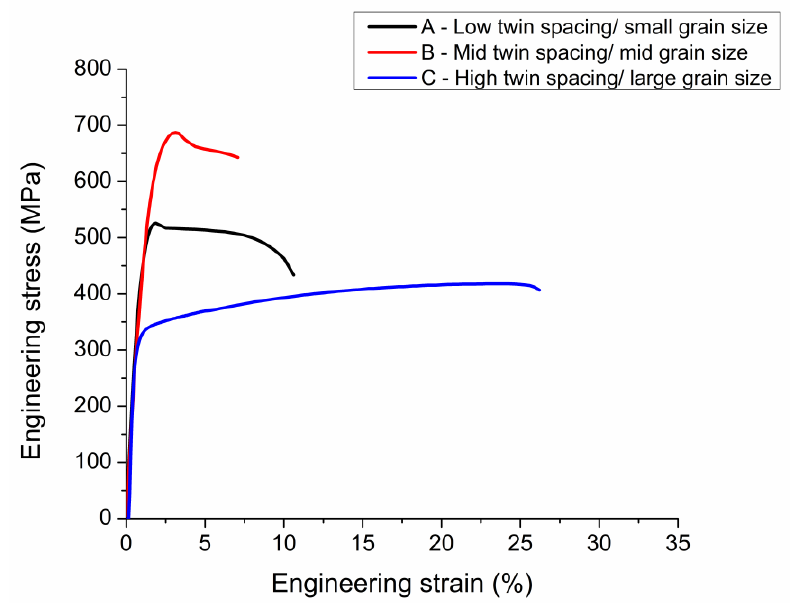
Materials 2020 , 13 , x FOR PEER REVIEW 6 of 11 Figure 4. Stress–strain curves of the three types of < 111 > -oriented nano-twinned Cu foils. The yielding Figure 4 . Stress–strain curves of the three types of <111>-oriented nano-twinned Cu foils. The yielding strength ranges from 297 to 698 MPa, and the elongation ranges from 6% to 26%. strength ranges from 297 to 698 MPa, and the elongation ranges from 6% to 26%. Grain boundary strengthening is a well-known strengthening mechanism in materials.